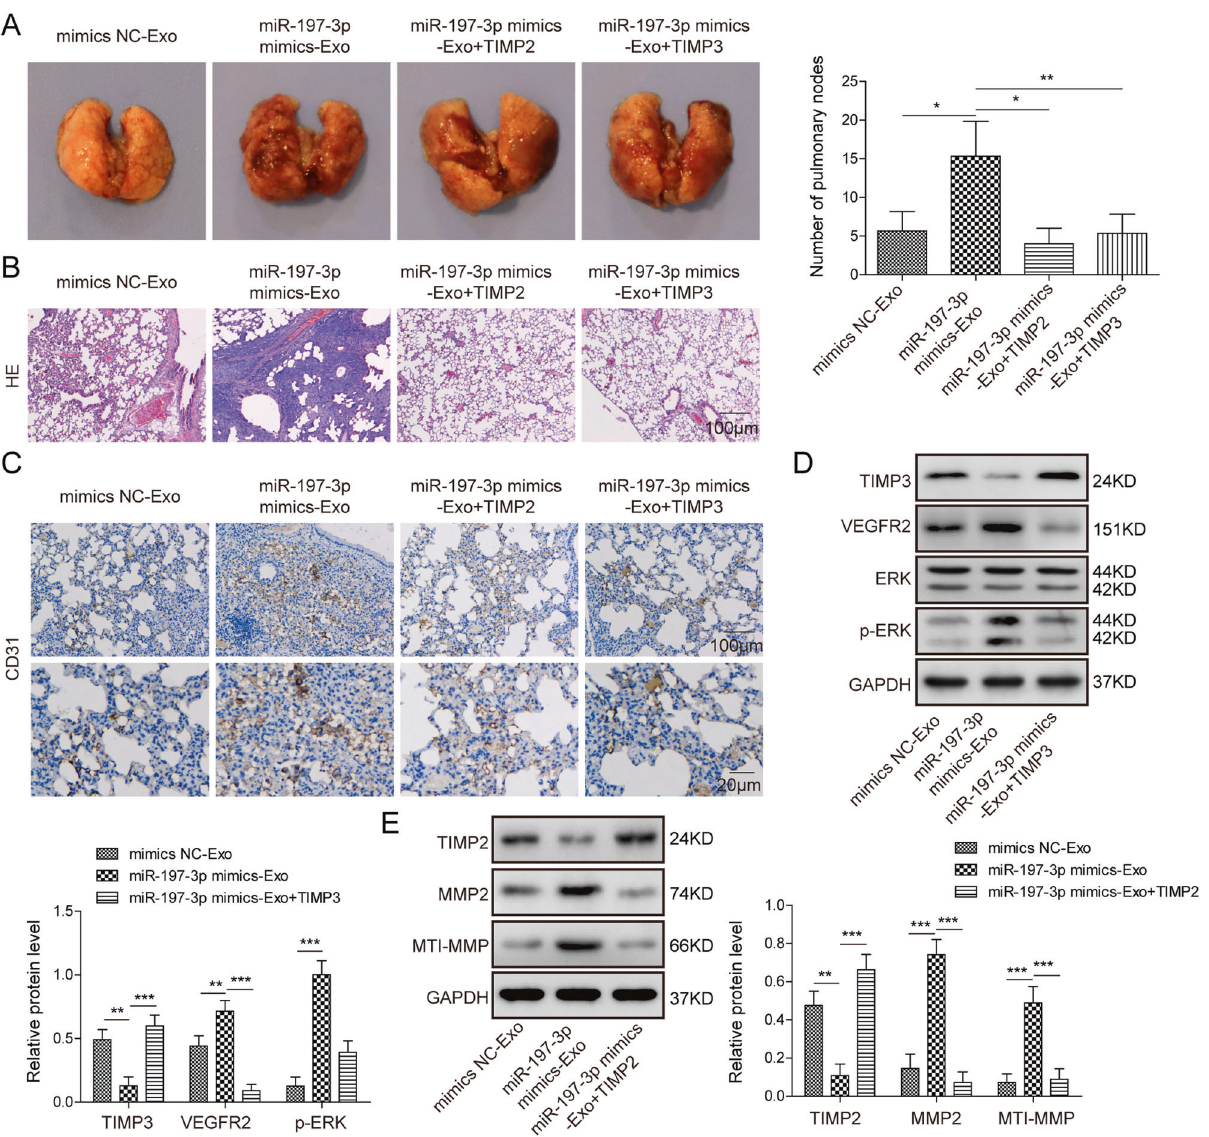
Fig. 8 Exosomal miR-197-3p promotes lung metastasis and angiogenesis in vivo by targeting TIMP2/3. A Photographs and quantitative analysis of pulmonary metastatic nodules. B Histopathological changes of lung tissues were assessed by H&E staining. C CD31 expression in pulmonary metastatic nodules was assessed by IHC. D The protein levels of TIMP3, VEGFR2, ERK, and p-ERK in pulmonary metastatic nodules were determined by western blot. E The protein levels of TIMP2, MMP2, and MT1-MMP in pulmonary metastatic nodules were determined by western blot. Data were representative images or were expressed as the mean ± SD of n = 3 experiments. * P < 0.05, ** P < 0.01, *** P < upregulation of miR-197-3p positively correlated with metastasis in LUAD patients. LUAD cells-derived exosomal miR-197-3p